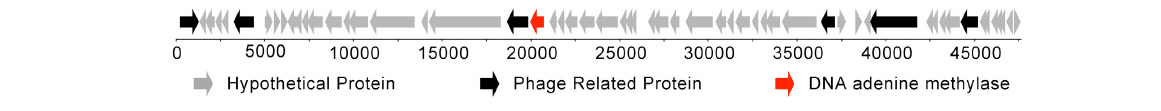
DNA cytosine methyltransferases. Hence, we predict that 5 (cid:2) - cytosine methylation is normal in both the 105 and 439